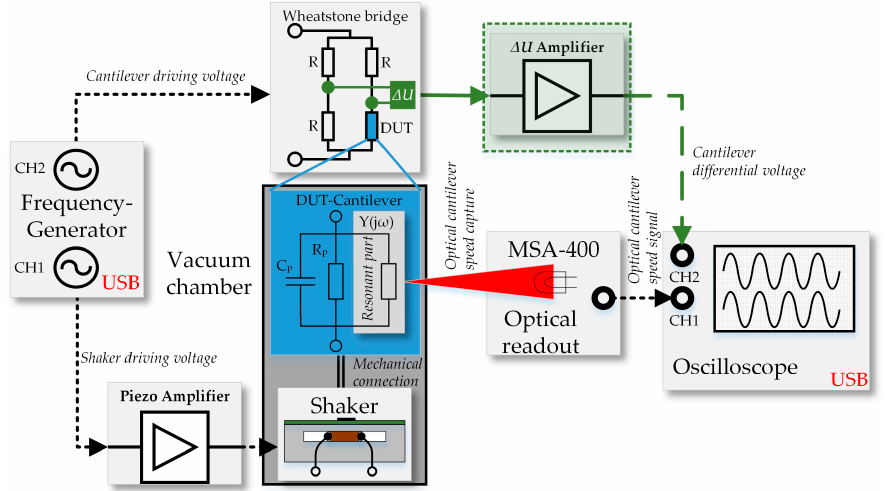
Figure 4. Block diagram of the measurement set-up used for characterization of the actively damped MEMS cantilevers. The electrical readout is highlighted in green.